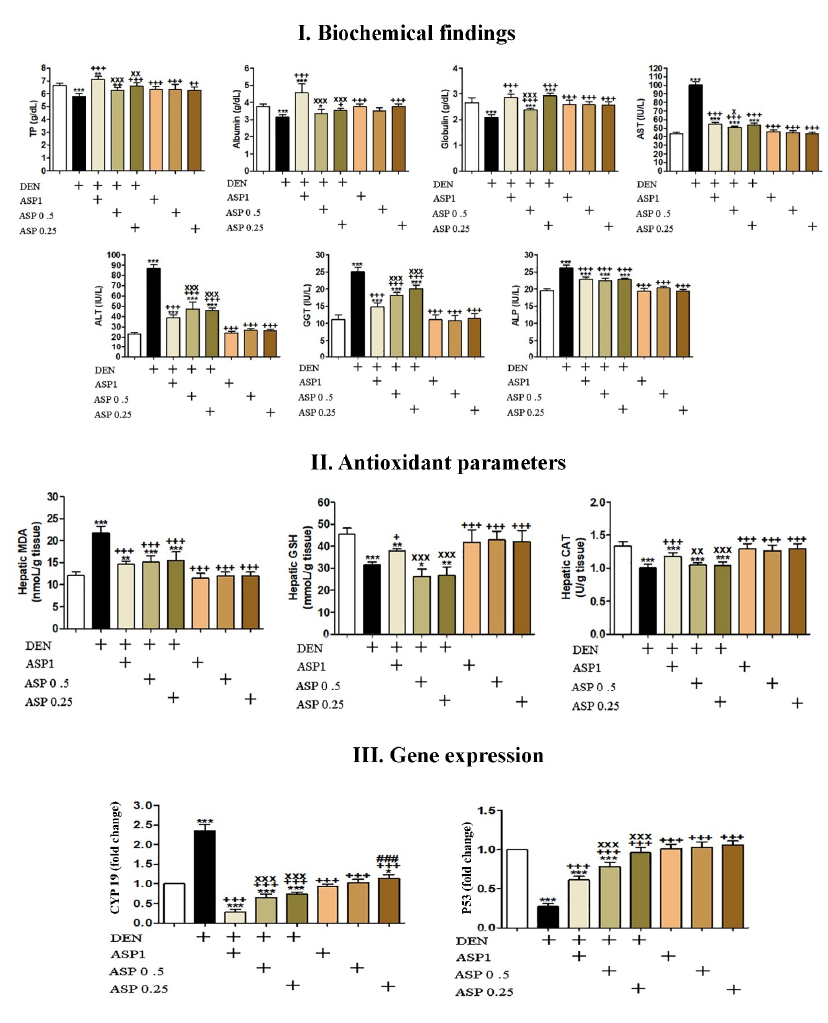
Figure 2. ( I ) Biochemical assessment of: Total proteins (TP), albumin, globulins, AST, ALT, GGT, and ALP. ( II ) Hepatic oxidative stress and antioxidant status: MDA, GSH, CAT. Data were analyzed with one-way ANOVA followed by Tukey’s multiple comparison test. * p < 0.05, ** p < 0.01, and *** p < 0.001 vs. Control. + p < 0.05, ++ p < 0.01 and +++ p < 0.001 vs. DEN. x p < 0.05, xx p < 0.01, and xxx p < 0.001 vs. DEN + ASP1. Error bars represent mean ± SD. n = 9. ( III ) Expression fold changes of cytochrome P450 ( Cyp19 ) and p53 genes in the liver. Data were analyzed with one-way ANOVA followed by Tukey’s multiple comparison test. * p < 0.05 and *** p < 0.001 vs. Control. +++ p < 0.001 vs. DEN. xxx p < 0.001 vs. DEN + ASP1. ### p < 0.001 vs. ASP1. Error bars represent mean ± SD. n = 9. Where: DEN: DEN supplied group, ASP1: group received A. awamori 1 mg/kg b.wt, ASP0.5: group received A. awamori 0.5 mg/kg b.wt, ASP0.25: group received A. awamori 0.25 mg/kg b.wt.